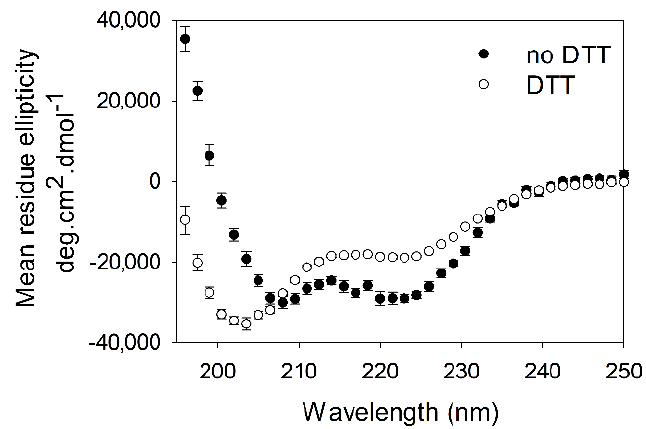
Figure 4. The R91P substitution in Tpm3.12 65–155 results in decreased helicity in the presence of DTT. CD spectra were measured at 0 ° C in 100 mM NaCl, 10 mM Na-Phosphate, pH 7.0, with or without 0.5 mM DTT.